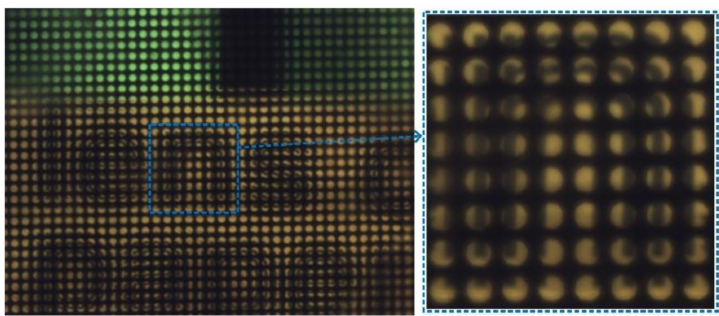
Figure 9. The raw light-field image and partially enlarged image captured by the plenoptic imaging system based on EC-LCMLA, the applied voltage signal is ~5.50 V rms . The image indicates obvious plenoptic imaging in Galilean